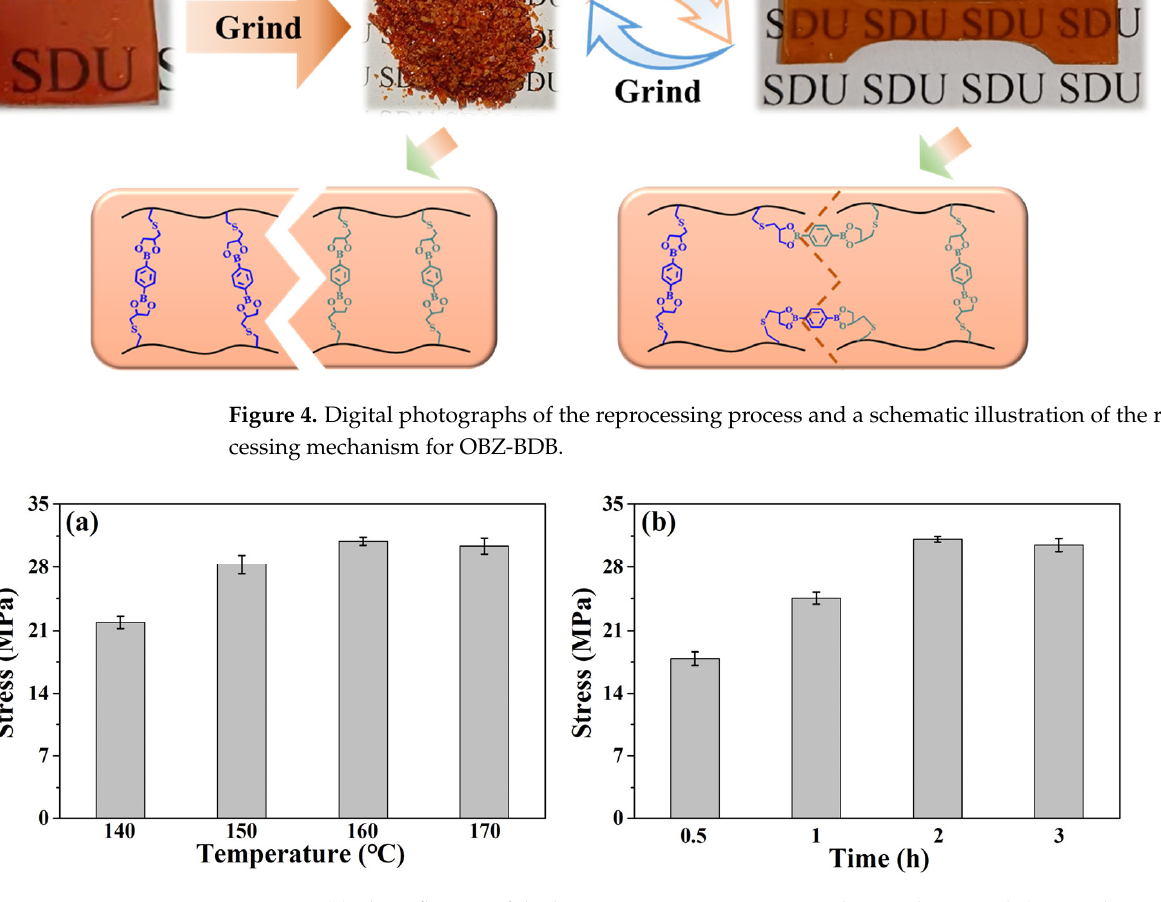
Figure 5. ( a ) The influence of the hot-pressing temperature on the tensile strength (time: 2 h, pressure: 16 MPa); ( b ) The influence of the hot-pressing time on the tensile strength (temperature: 160 °C, pressure: 16 MPa).